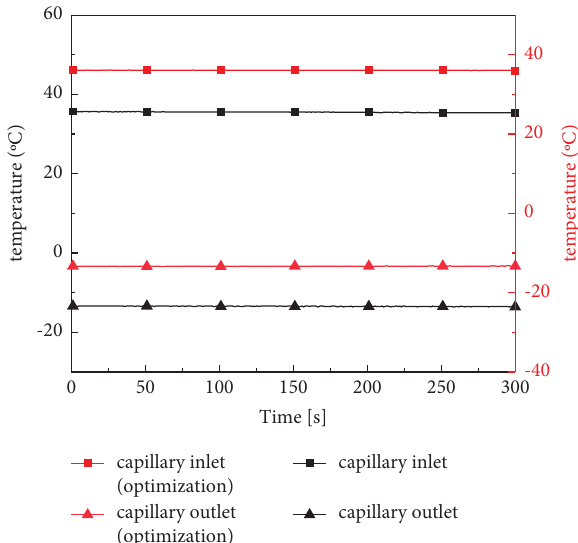
Figure 8: The temperature of the capillary inlet and outlet before and after aeration.